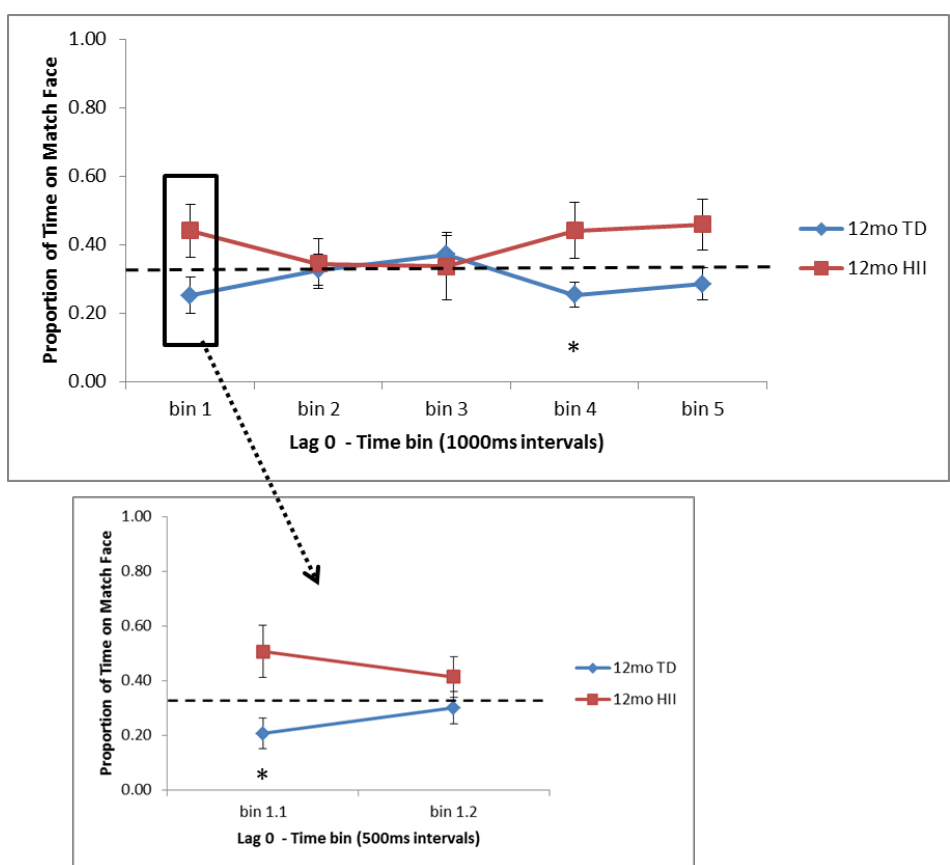
Figure 2. Proportion of time fixating the matching face for Lag 0 trials for the five 1000 ms time bins (bins 1–5) and the two 500 ms bins in the first 1000 ms (bins 1.1 and 1.2) for 12-month-old typically developing infants (TD) and hypoxic–ischemic injured infants (HII). Looking to the match face was significantly lower than expected by chance for 12-month TD infants in bin 4 (3000–4000 ms) as well as in bin 1.1 (0–500 ms). Chance is illustrated with a dashed line; error bars indicate the standard error of the mean. * p < 0.05.